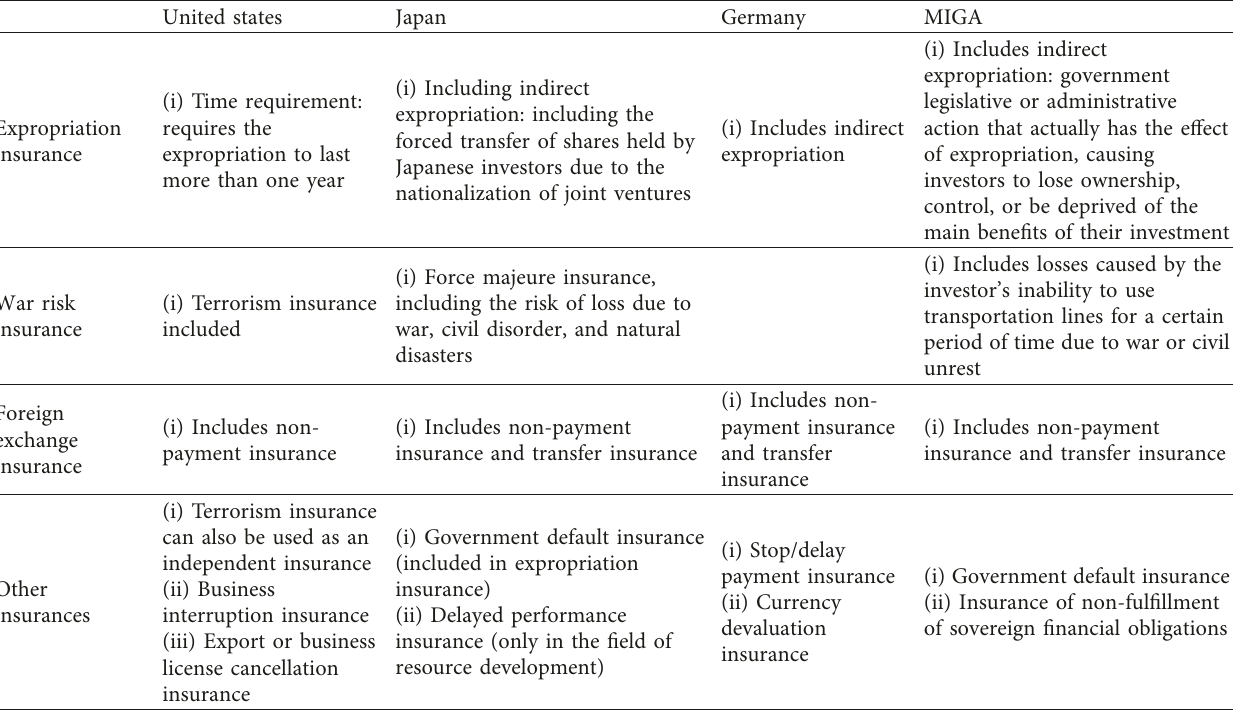
Table 1: Comparison of overseas investment insurance coverage in different